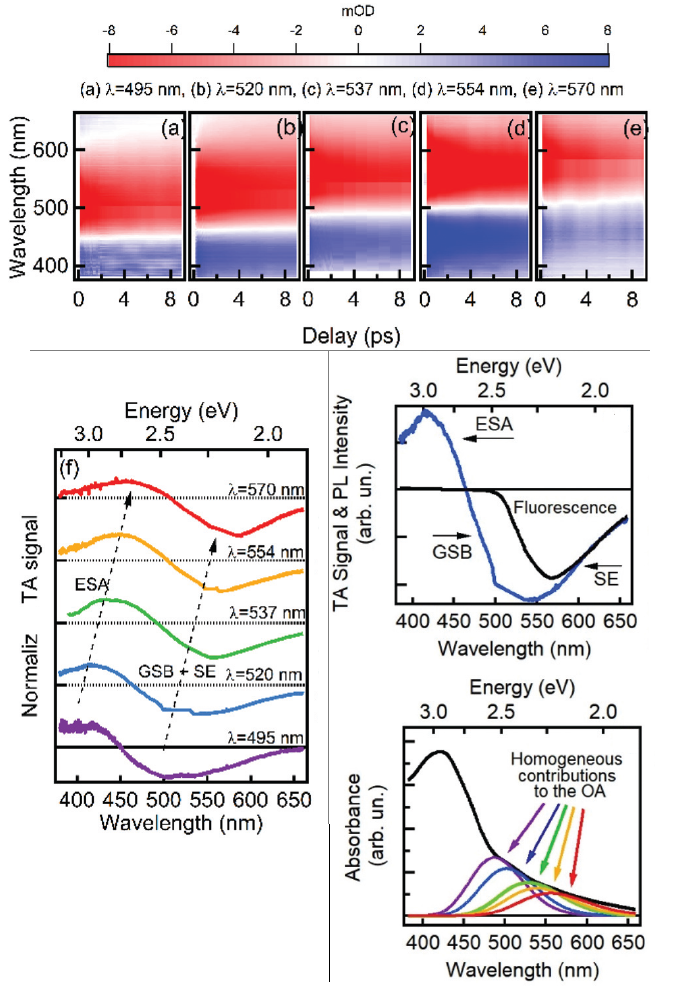
Figure 12. ( top ): femtosecond TA data excited at different wavelengths. ( bottom left ): data recorded at 50 ps from photo-excitation, showing the hole burning within the optical absorption band, and the photoselection across a family of transition with continuously variable energies. ( middle right ): decomposition of the TA data in contributions due to ground state bleaching (GSB), excited-state absorption (ESA) and stimulated emission (SE). The SE is compared with the steady-state fluorescence signal. ( bottom right ): comparison between steady-state optical absorption (OA) and individual homogeneous contributions obtained from hole burning data. Reproduced with permission from